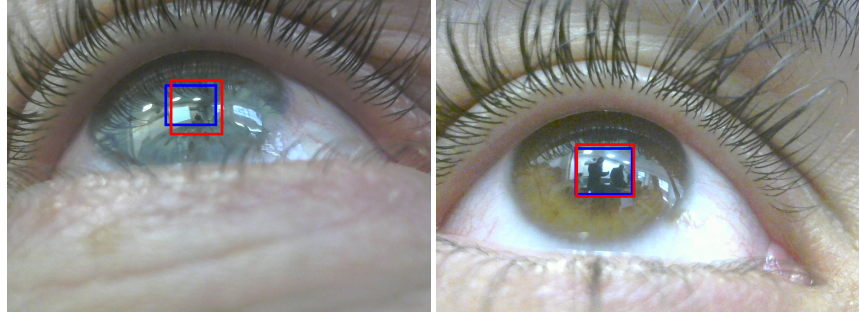
Figure 8. Automatic detection (red) vs. manually labeled (blue) of pupils. Left : IoU = 0.6, right : IoU = 0.84. For each pupil center pair in the RGB image (computed and manually labeled), we also compared the automatically computed 3D gaze using the manually labeled center and used the angle between vectors as well as the Euclidean distance (in pixels) between pupil centers as a metric for comparison. Figure 9 illustrates the comparison process.